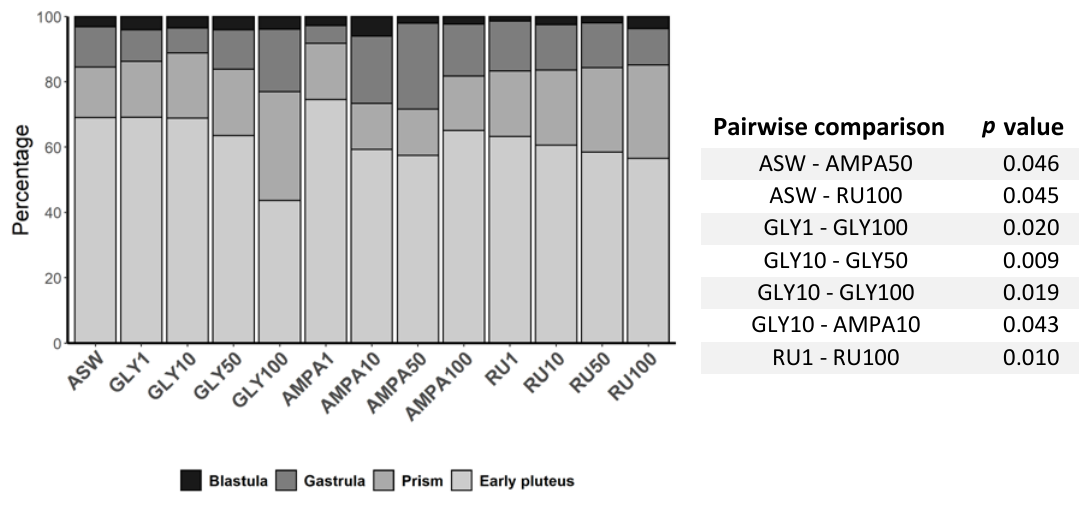
Figure 2. Percentage of developmental stages at 24 hpf in larvae reared in control conditions (ASW) and in four concentrations (1, 10, 50, 100 µ g / L) of three contaminants: glyphosate (GLY), AMPA and Roundup (RU). Statistically significant pairwise comparisons are reported in the table on the right.